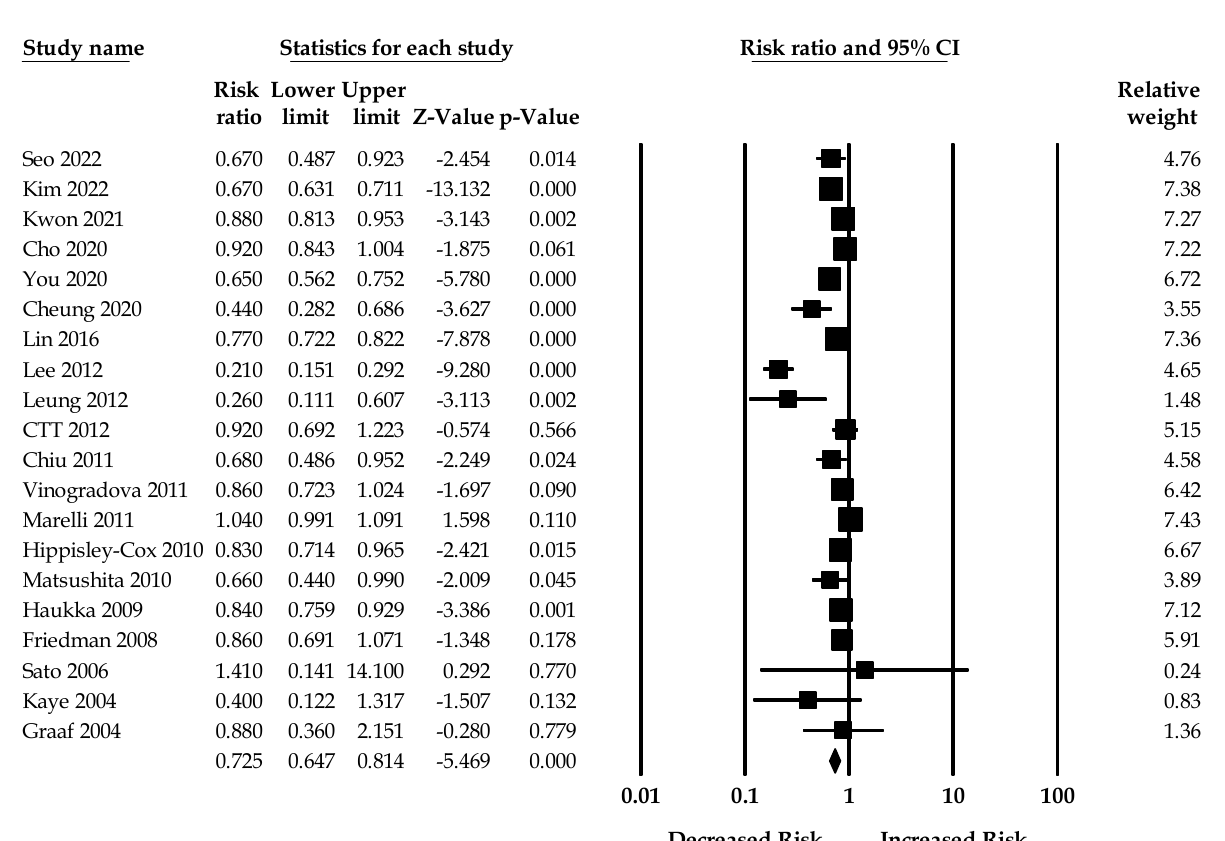
Figure 2. Association between statin use and the risk of gastric cancer [17,25–43].